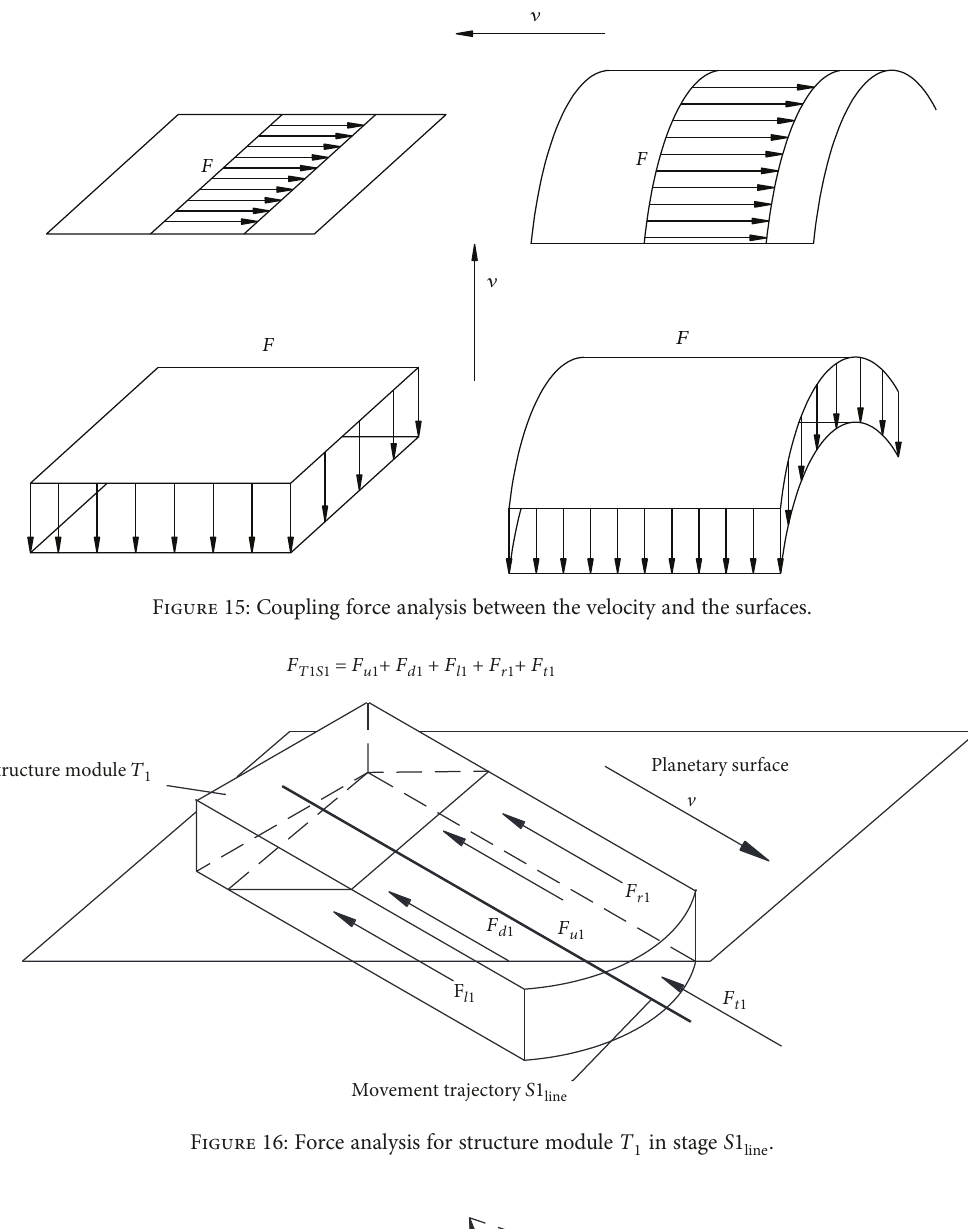
Figure 16: Force analysis for structure module T